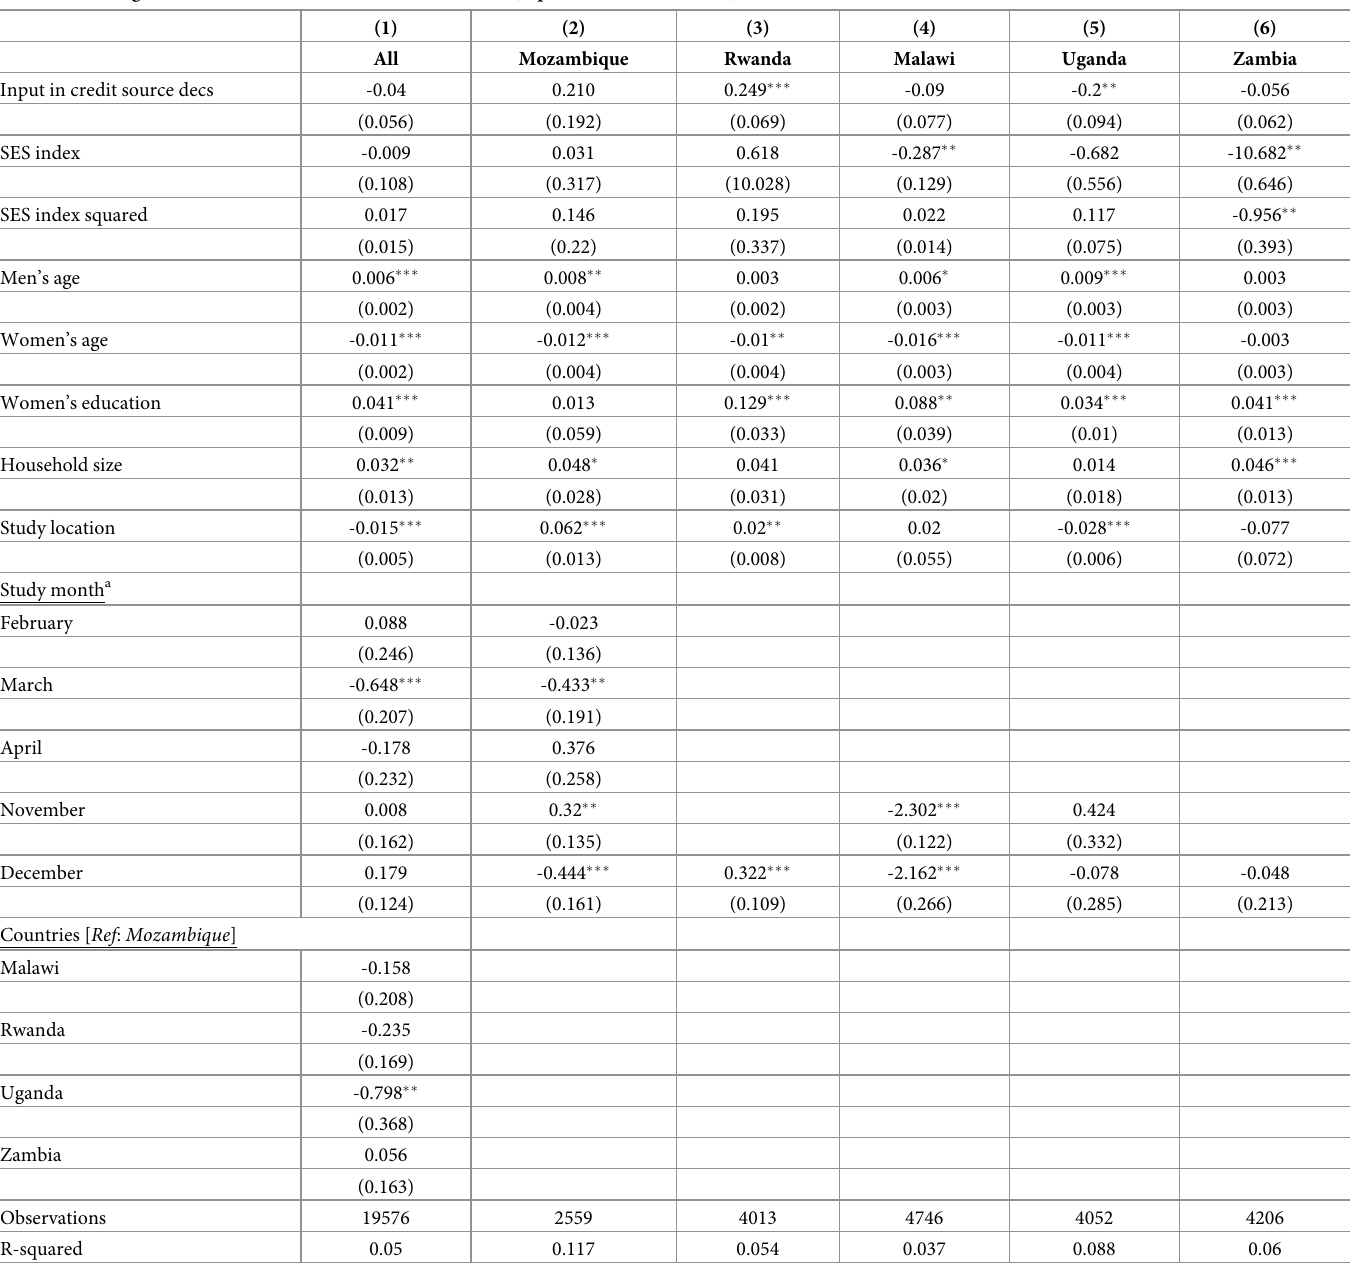
Table 9. OLS regression results for WDDS–resources domain (input in � 1 credit